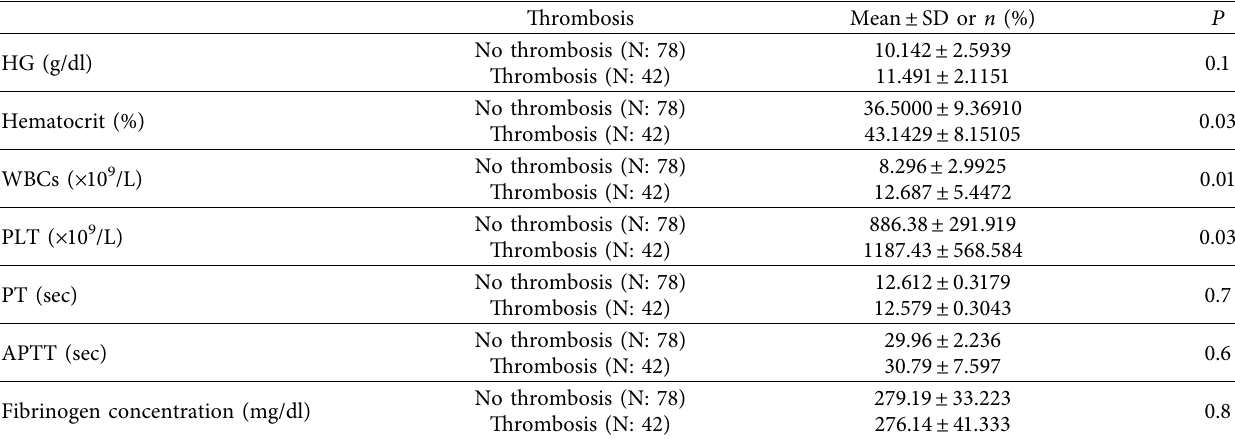
Table 3: Multivariate analysis of thrombotic risk of ET patients.